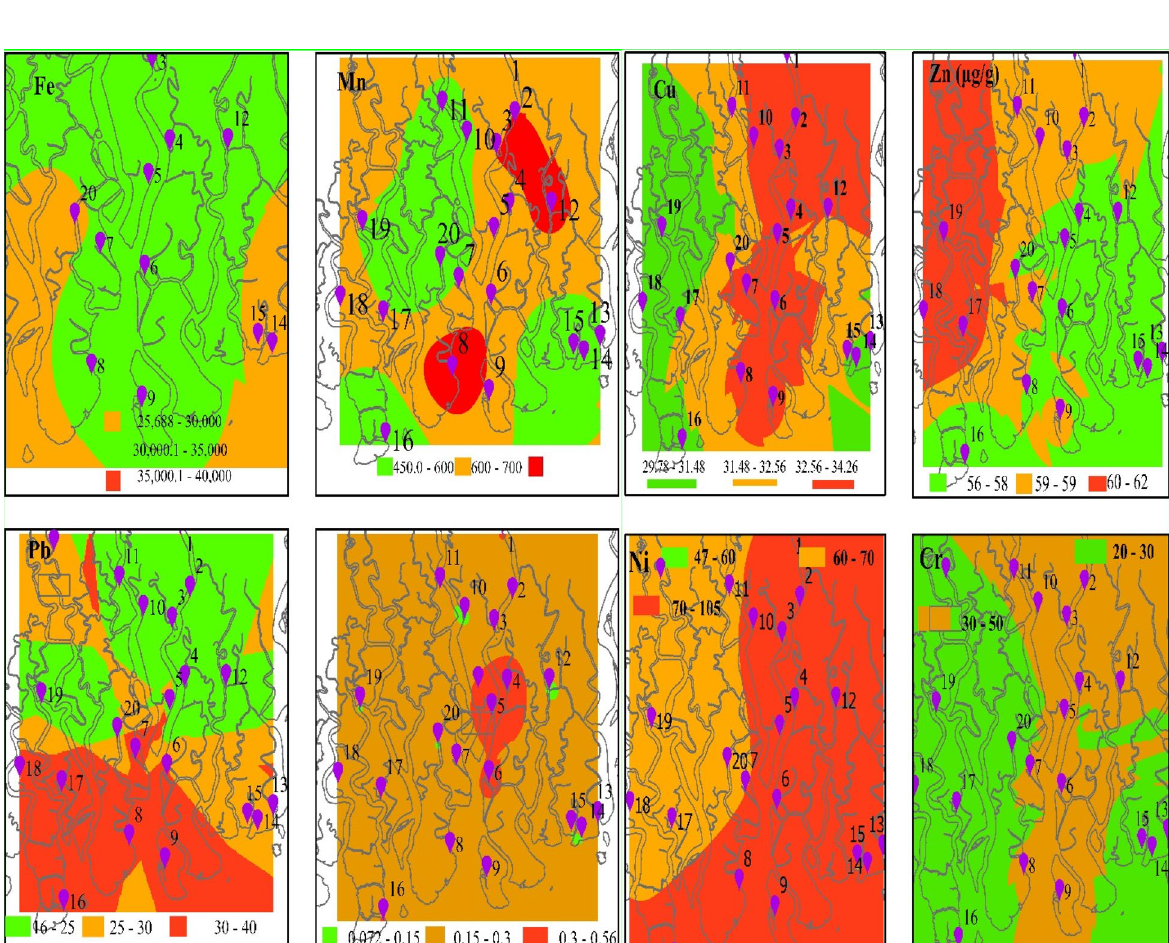
Figure 2. Spatial distribution of trace metals in Bangladesh Sundarban Soils (ArcGIS